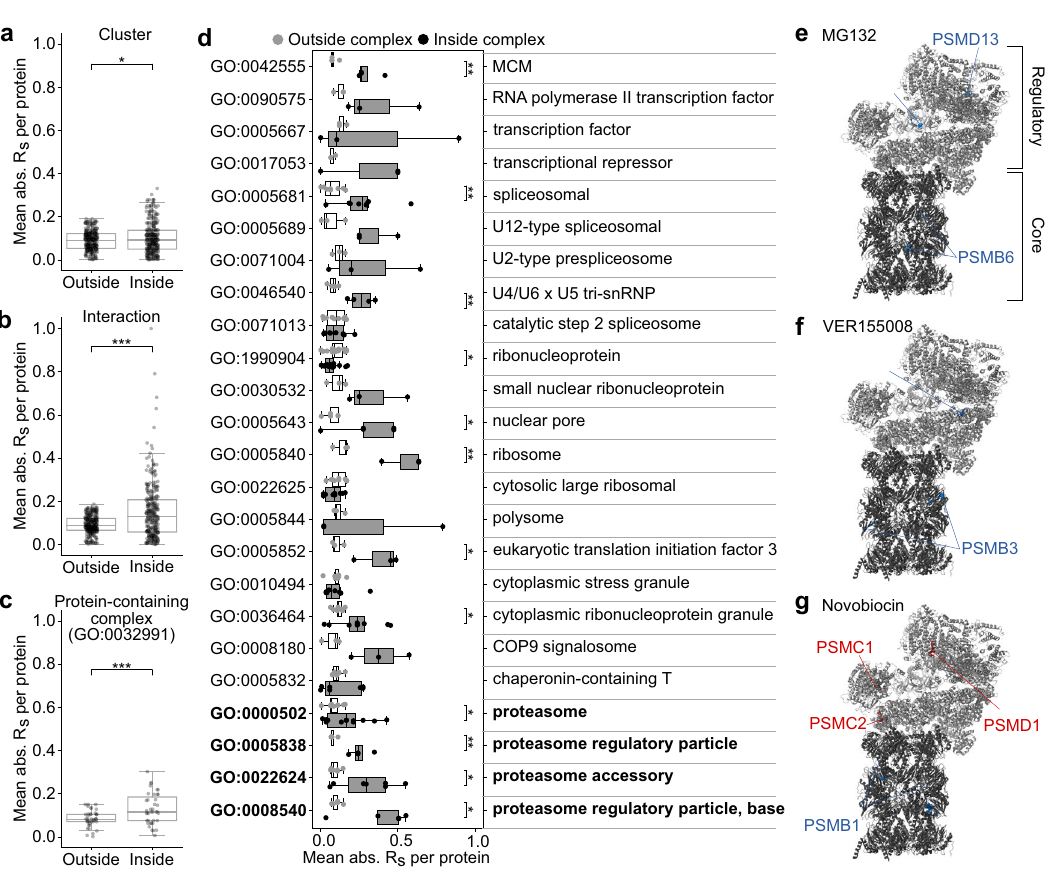
Fig. 4 Unique conformational remodeling of macromolecular complexes is speci fi cally associated with different stimuli. Correlation comparison for a functional clusters presented in Fig. 3, b interacting proteins, and c , d proteins annotated with gene ontology terms associated with macromolecular complexes. The pairwise correlation strength was calculated for all comparison proteins then binned according to whether one (outside) or both (inside) proteins identi fi ed with the feature of interest. The mean for each protein in both bins was then calculated and the resultant inside and outside values were compared according to a two-tailed t -test. * p < 0.05, ** p < 0.01, *** p < 0.001. Terms related to the proteasome are highlighted in bold text. e – g Human 26 S proteasome ribbon structure adapted from PDB: 6MSB, consisting of the core 20 S proteasome (dark gray) and a single 19 S regulatory particle (light gray). Variations of the structure are presented for e MG132, f VER155008, and g novobiocin, whereby individual cysteine-containing peptides are colored according to their increase (red) or decrease (blue) in reactivity. The corresponding protein subunits are labeled with an equivalent color scheme. In a – d , individual points are overlayed on boxplots displayed as follows: center line corresponds to the median; box limits display upper and lower quartiles; and where shown, whiskers extend to the last or fi rst data point that is within 1.5× the interquartile range of the box limits in the upper and lower directions respectively. Source data are provided as a Source Data fi